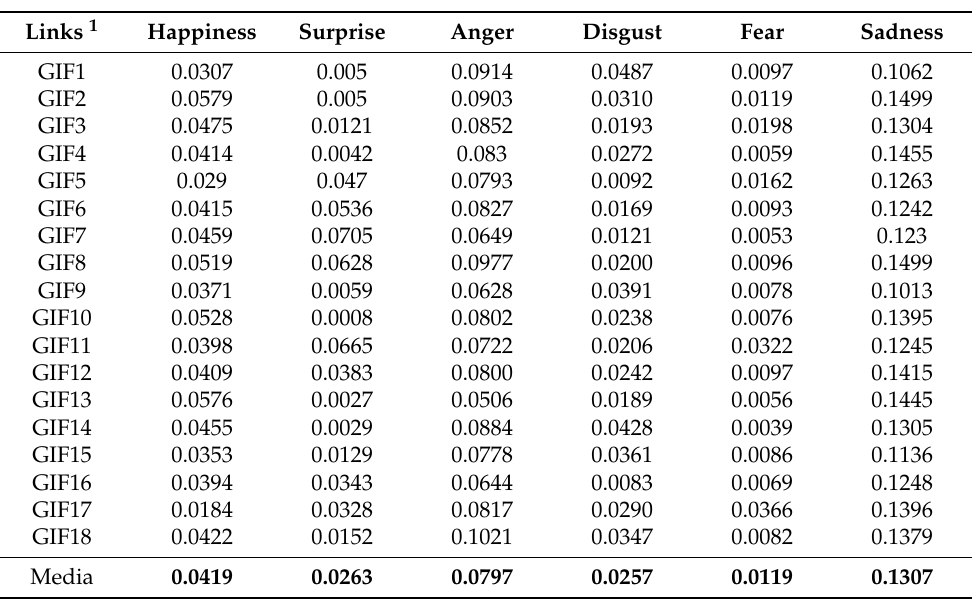
Table 2. Types of emotions registered in each GIF by the face